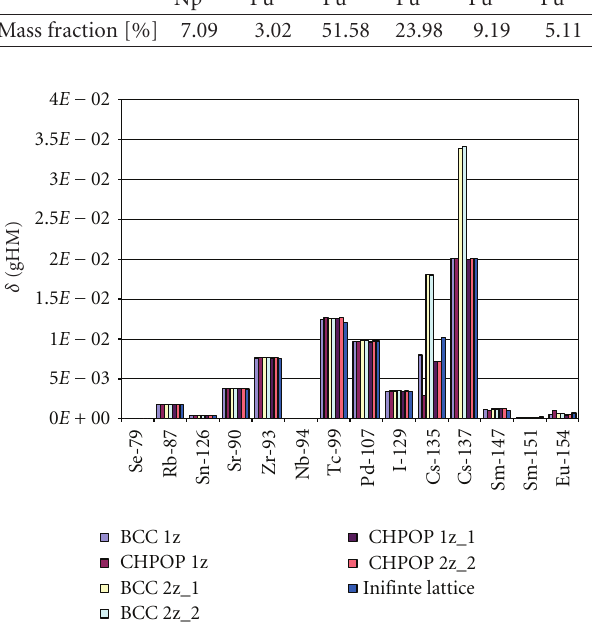
Figure 4: Production (grams) of some FPs per initial HM mass in the di ff erent PBMR core models (after 1063 EFPD).